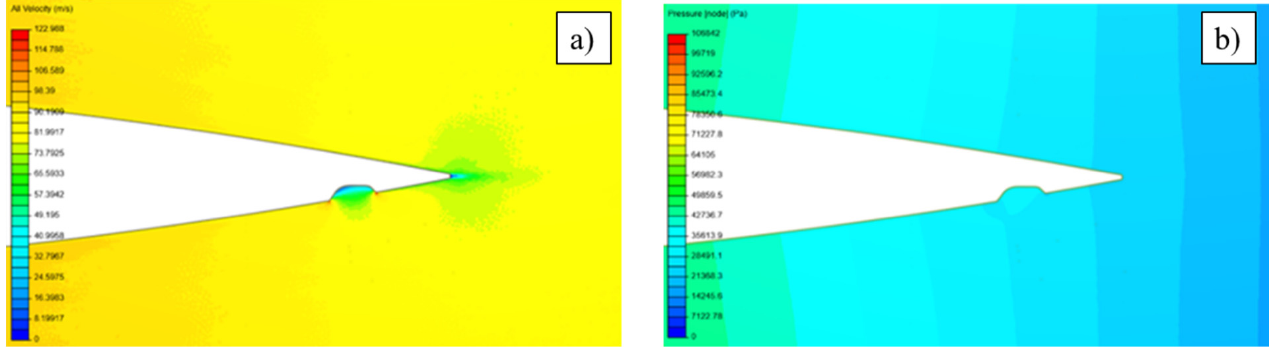
Figure 16. Profiles of total ( a ) velocity and ( b ) pressure over dimples aerofoil, SimScale simulation.